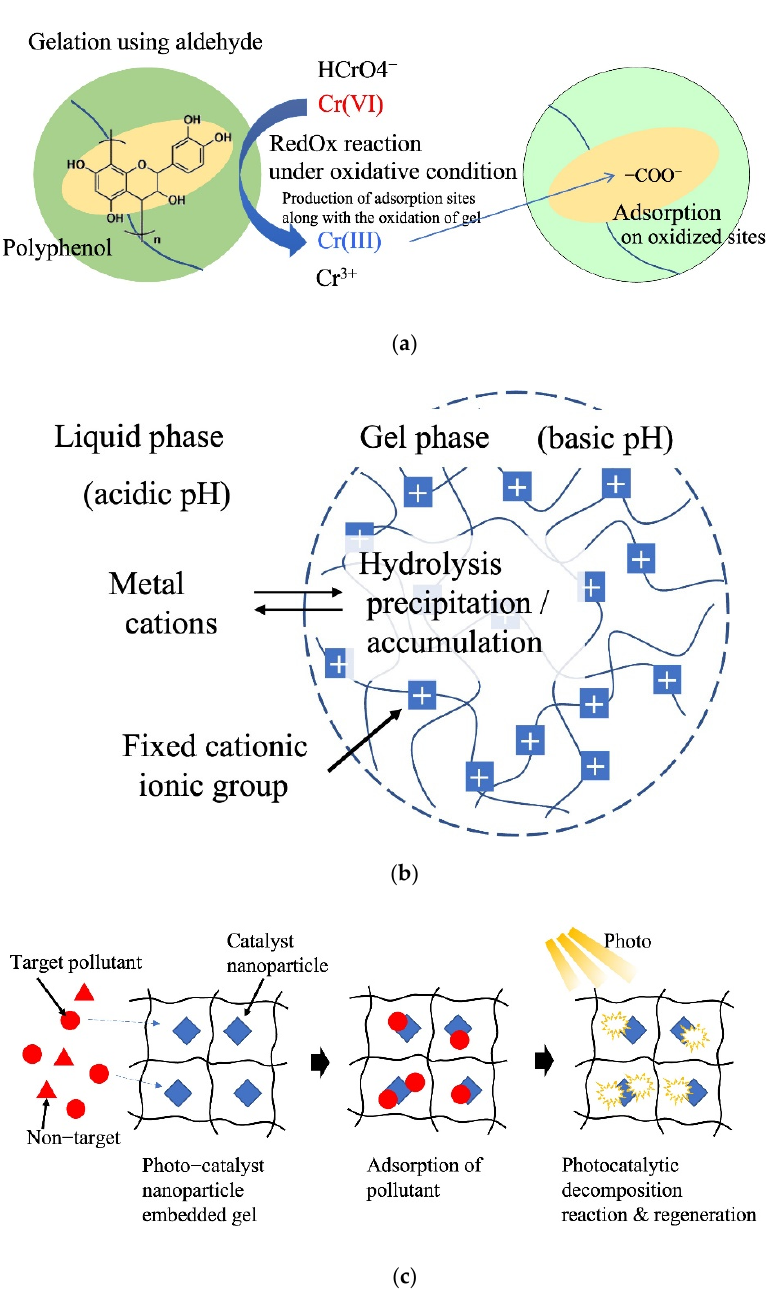
Figure 6. Reactive adsorption system. ( a ) Tannin gel redox adsorption system. ( b ) Hydrolysis of metal cations. ( c ) Adsorption and catalysis reaction.